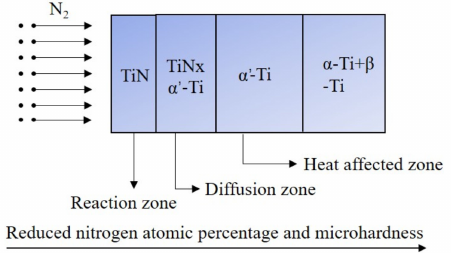
Figure 11. Schematic presentation of the phase distribution during the laser nitriding of titanium alloys.